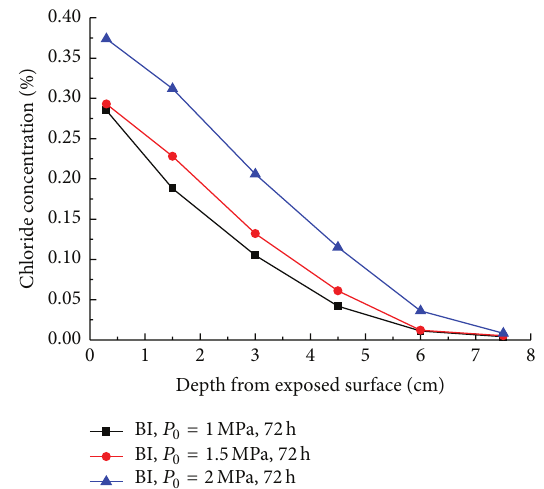
Figure 5: Chloride concentration profile under different pressuring time and solution concentration.